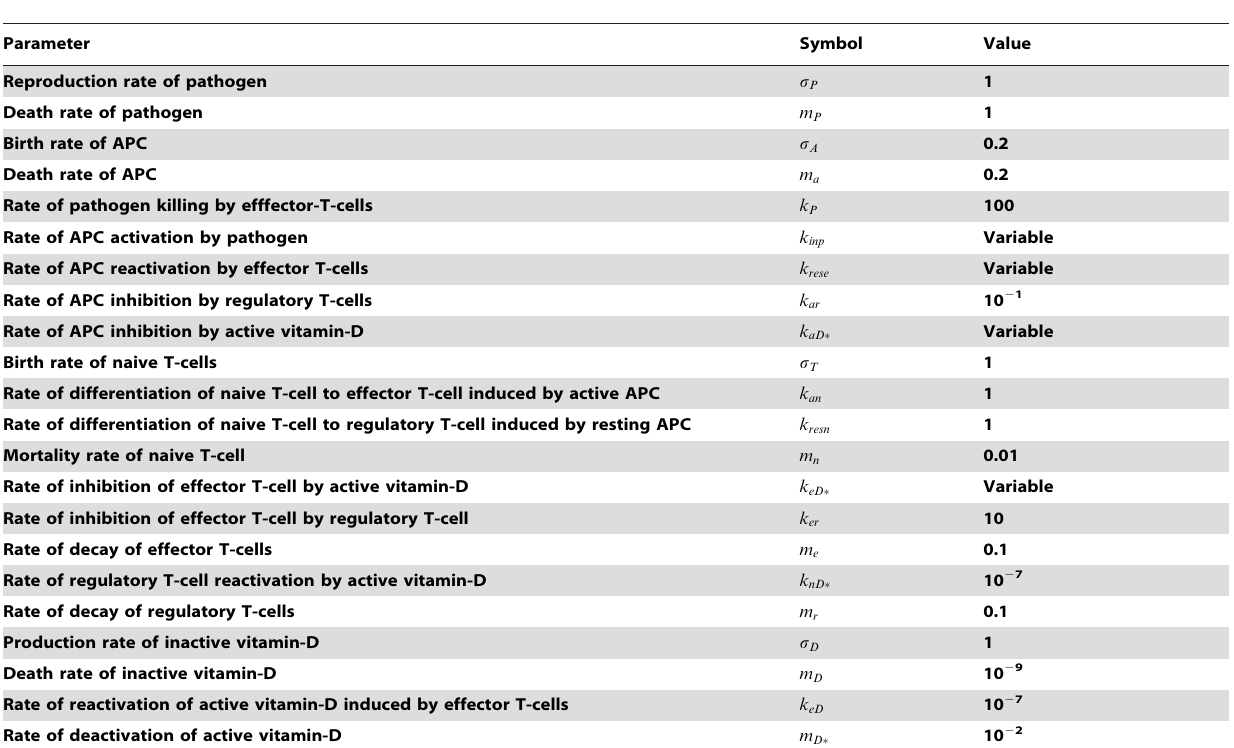
Table 1. Basic parameter values (*time duration is taken as ‘‘days’’).